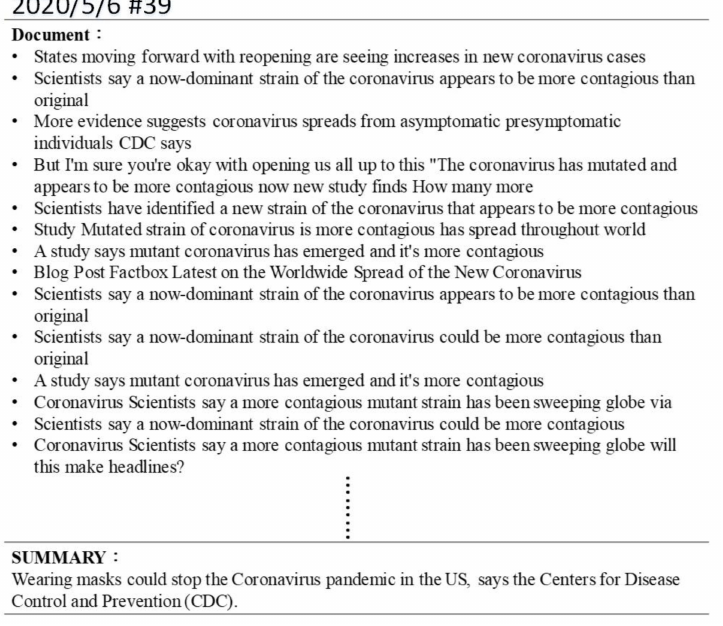
Figure A7. A sample resulting summary of formulated event topics (6 May